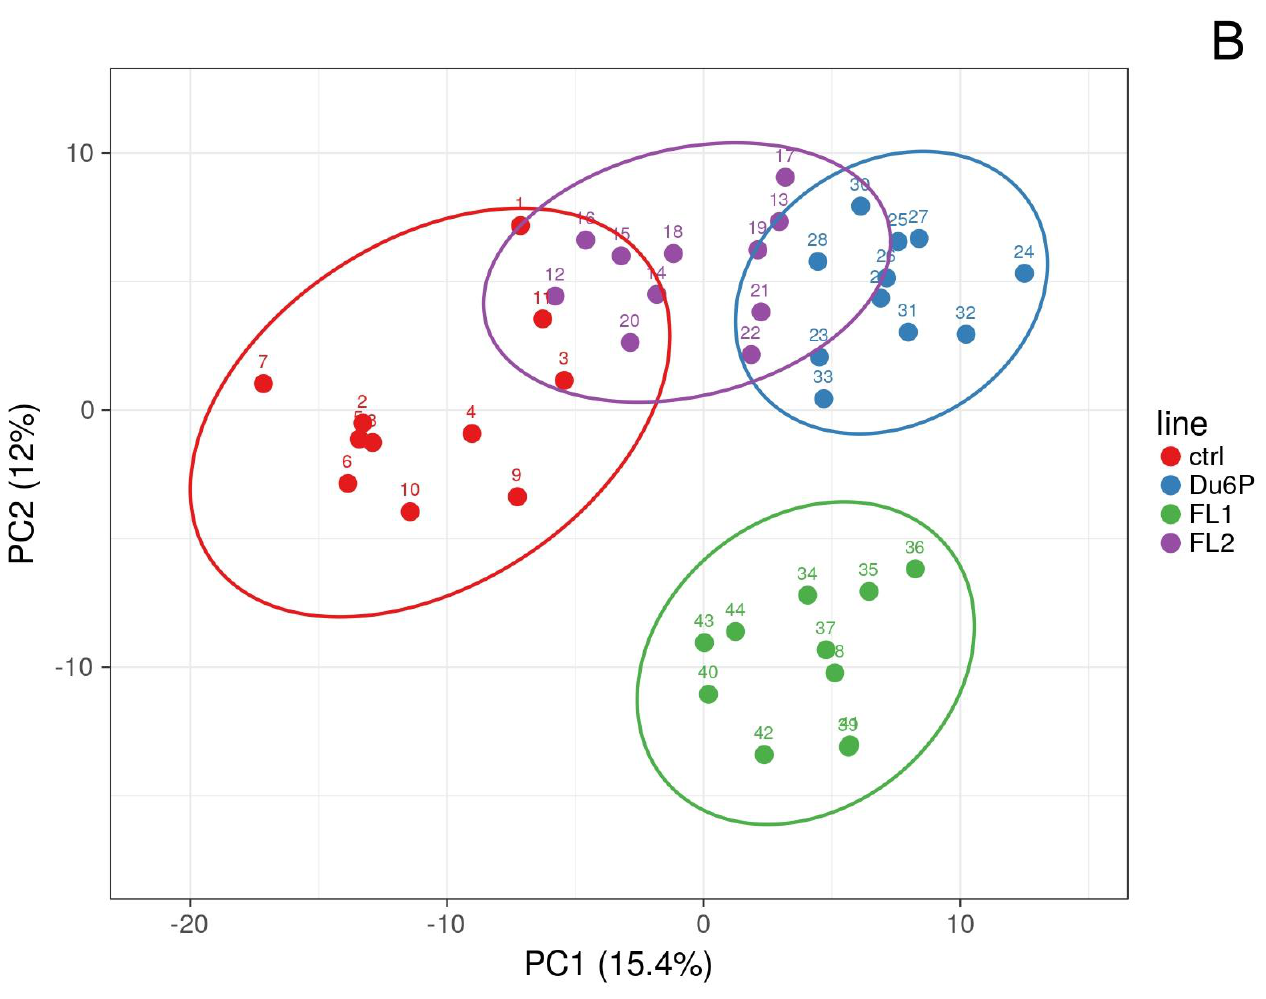
Figure 11. Heatmap ( A ) of all the types of FAs (S/M/P: SFAs, MUFAs and PUFAs, in red, blue and green) in all the analyzed tissues (different tissues in different colors) and principal component analysis (PCA) ( B ) in control (red), DU6P (blue), FL1 (green) and FL2 (purple).